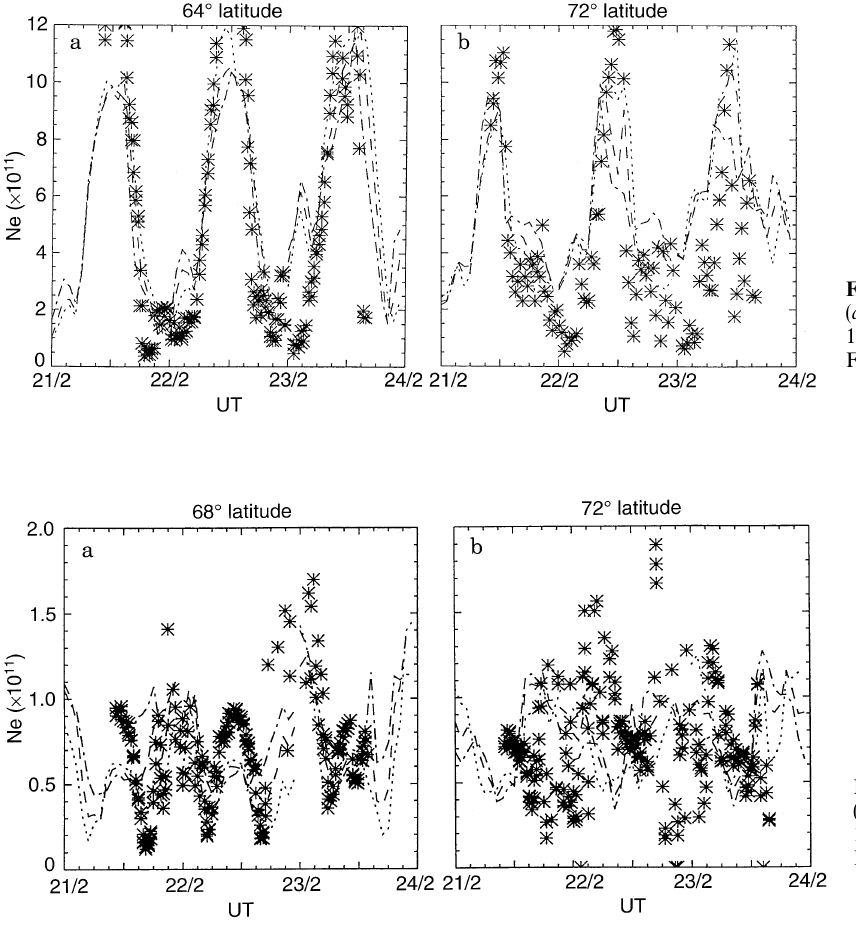
Fig. 13a, b. Modelled ( lines ) and measured ( asterisks ) Ne at 140 km for 21 — 23 February 1990. a 68 ° , b 72 ° . The lines are the same as Fig. 9